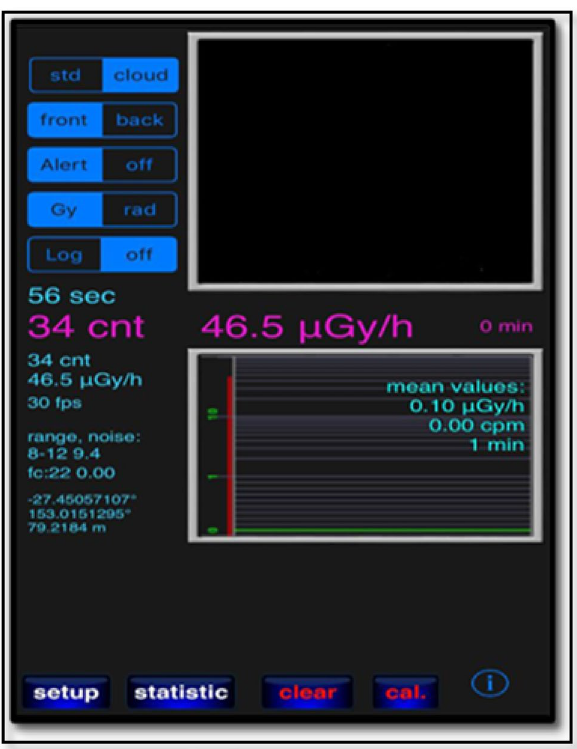
Figure 1. Screenshot of the RadioactivityCounter app, including the camera (front or back can be used), alarm panel, measurement scale (µGy/h), log button (for recorded data to be saved), setup button (to adjust background app activity) and statistic button (to display data as a spectrum or as a bar graph that can be converted to a Comma Separated Values (CSV) file and sent by